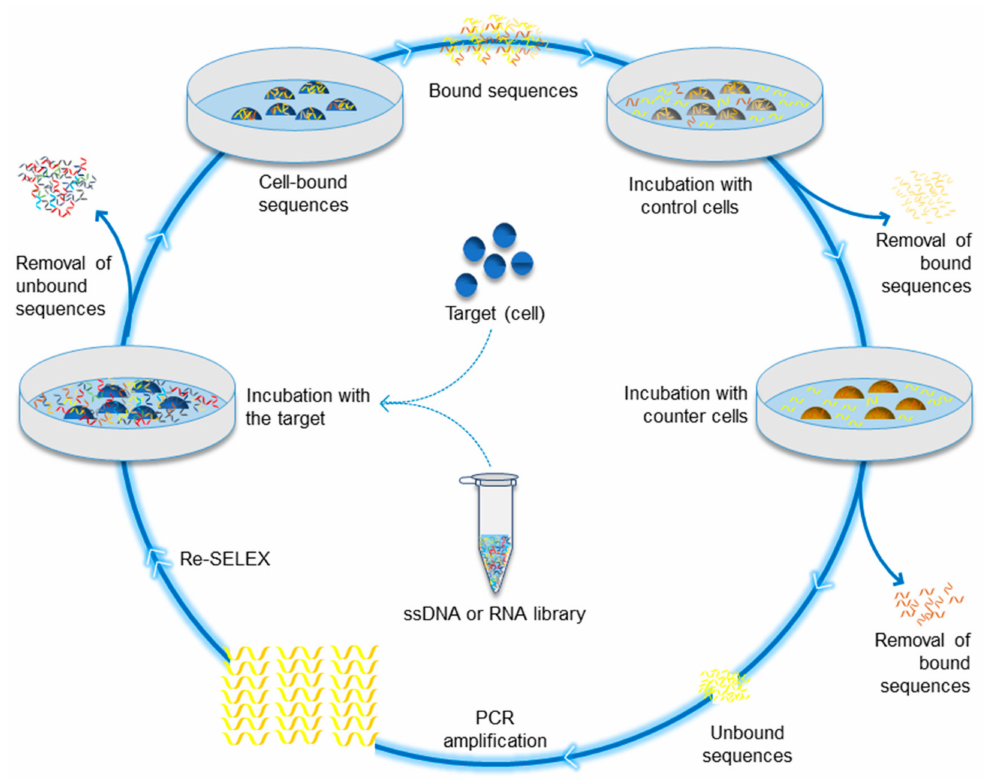
Figure 1. Cell-SELEX aptamer selection method. It consists of three major steps that can be interspersed with sub-steps: a. preparation of the ssDNA or RNA library, b. incubation of the target molecules with the library as a positive selection step, and c. amplification of the selected and recovered strands. Some sub-steps can be performed, whether before or after the positive selection, such as incubation with counter cells in order to remove the non-specific binding and enhance the selection